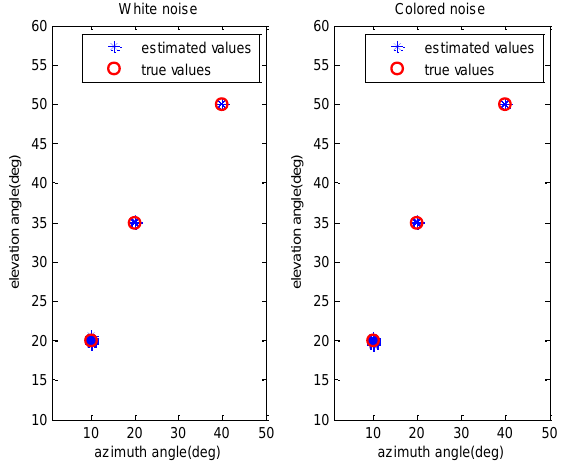
Figure 3. The estimated 2D DOAs of SDMS method with 100 Monte Carlo runs.